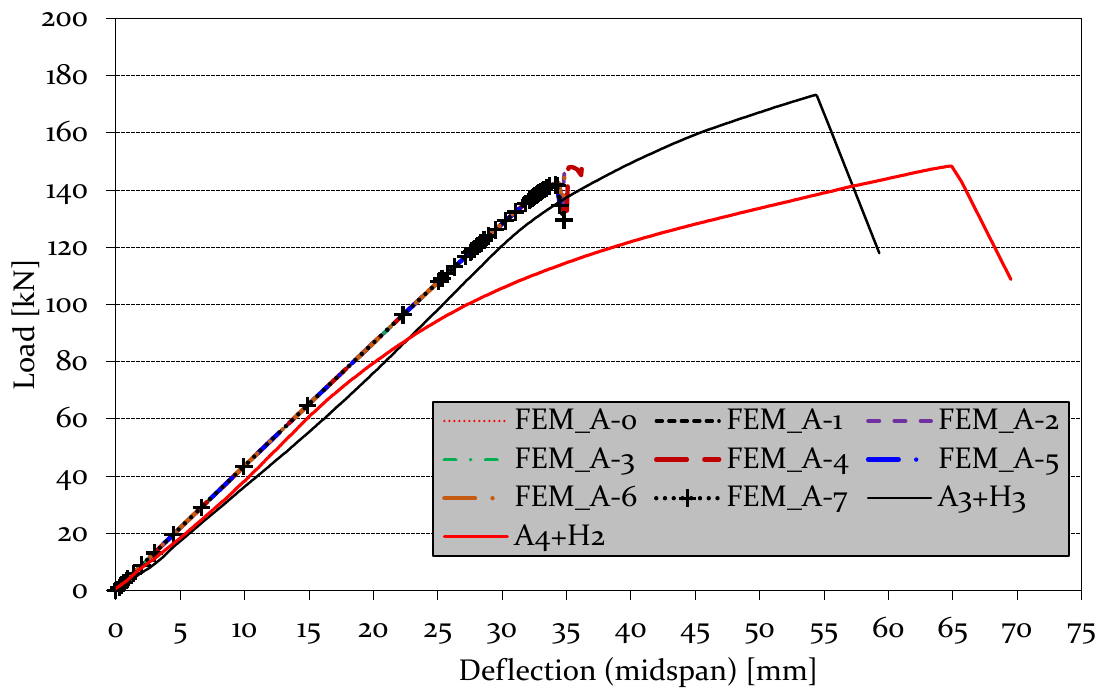
Figure 12. Comparison of bending load–displacement relationship between FEM and experimental tests.